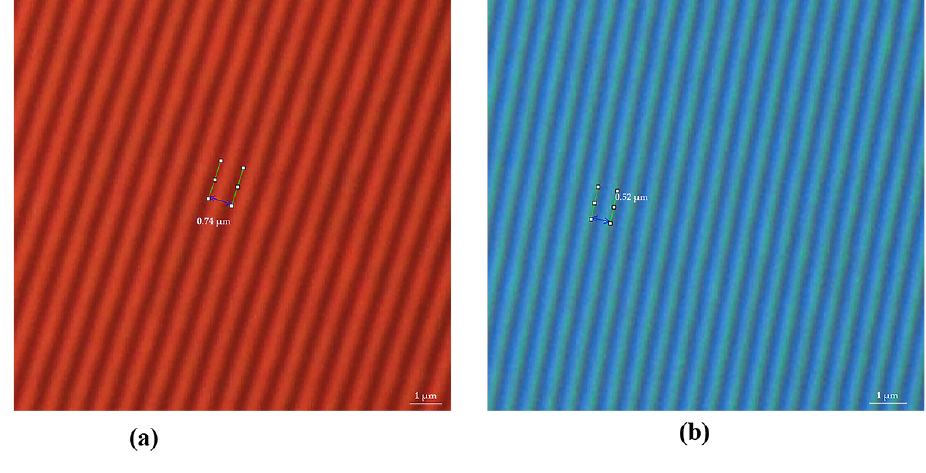
Figure 7. The POM images of PVGs. ( a ) R+G2. ( b )